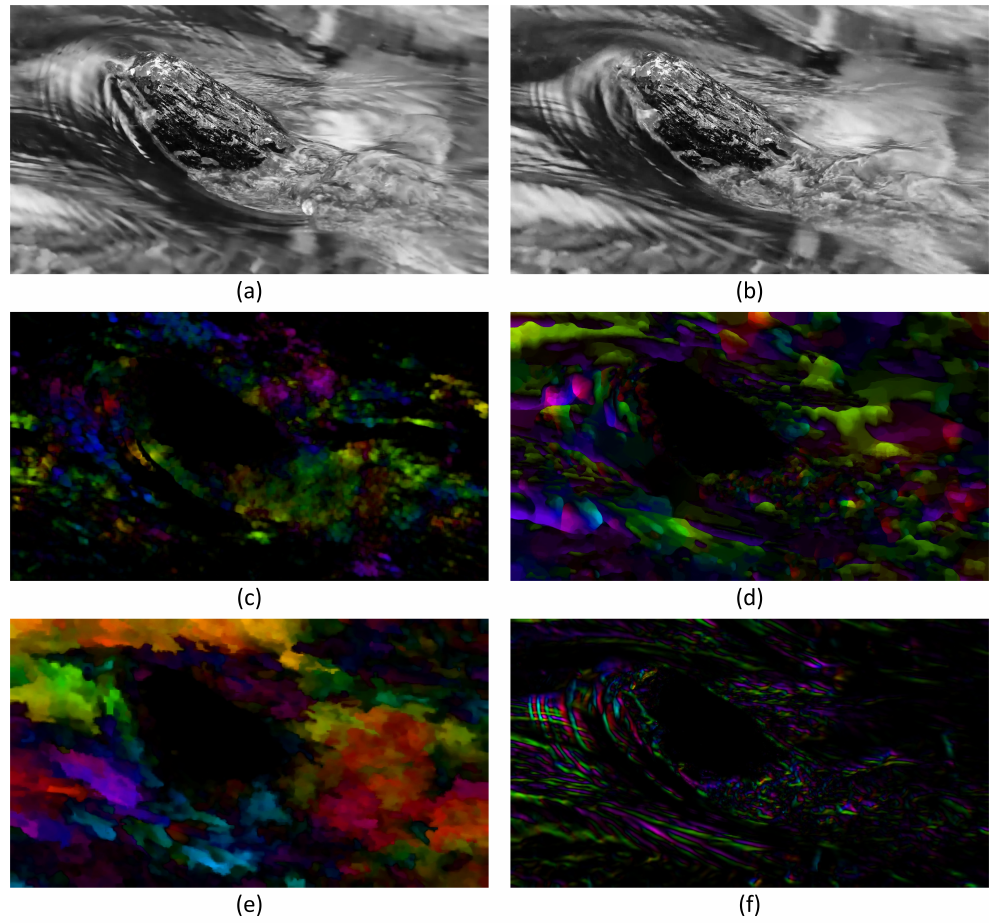
Figure 3. Experimental plots of turbulence video: ( a , b ) two adjacent frames of turbulence video; ( c ) HSV optical flow map of FB algorithm; ( d ) HSV optical flow map of TV-L1; ( e ) HSV optical flow map of DIS; ( f ) HSV optical flow map of